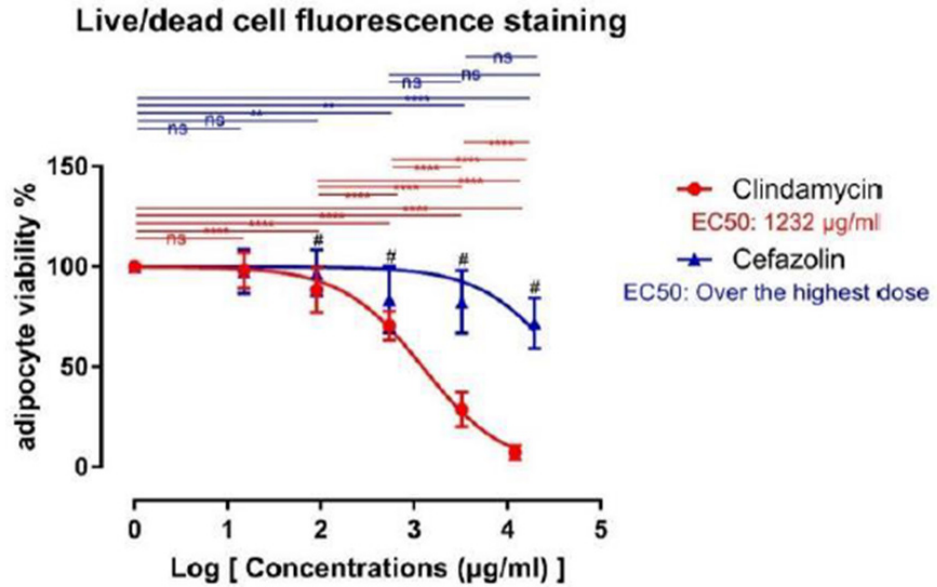
Figure 2. Sigmoidal dose-response curve for live/dead staining. Data are shown as mean ± standard deviation. Asterix denotes statistically significant difference vs. the control group (ns = not signifi- cant; ** = p < 0.01; **** = p < 0.0001). Brackets indicate statistically significant differences between corresponding groups of clindamycin and cefazolin treated adipocytes (# = p < 0.05). ns means non-significant. EC50 characterizes the concentration leading to a 50% reduction.